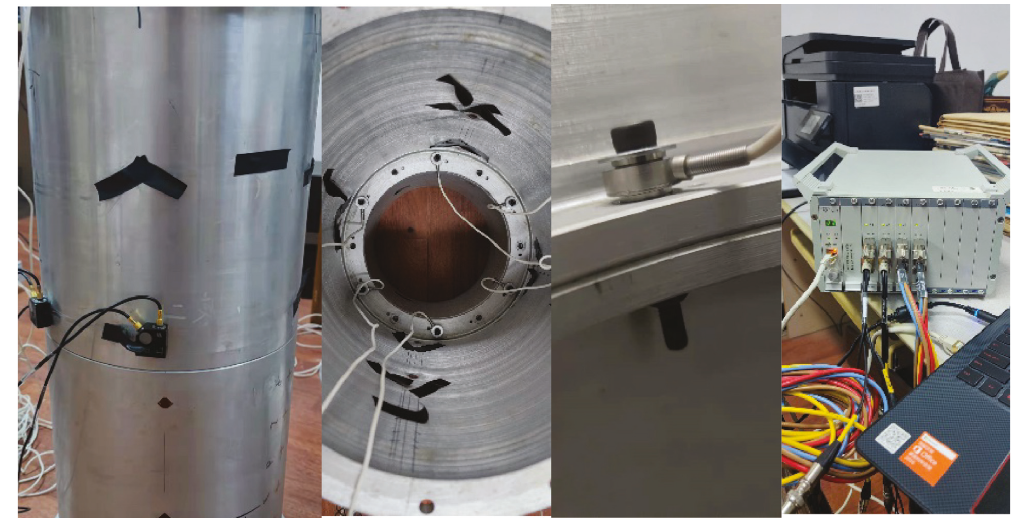
Figure 28: Experimental